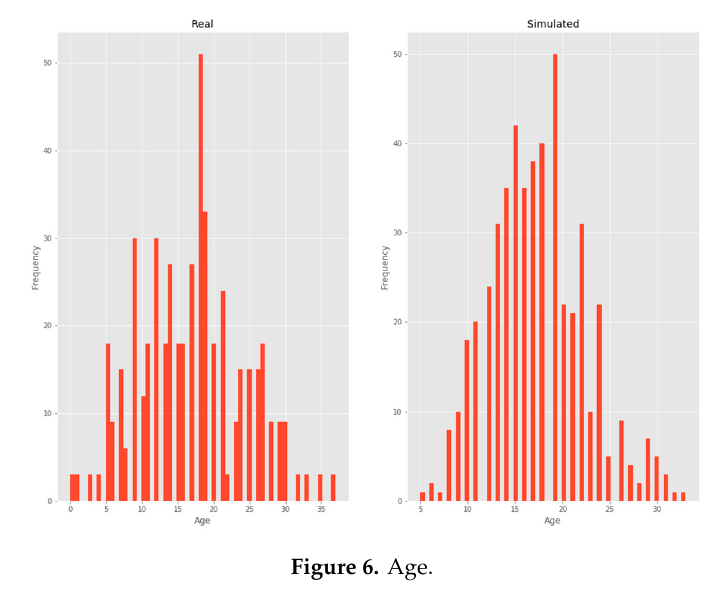
Figure 6. Figure 6. Age.